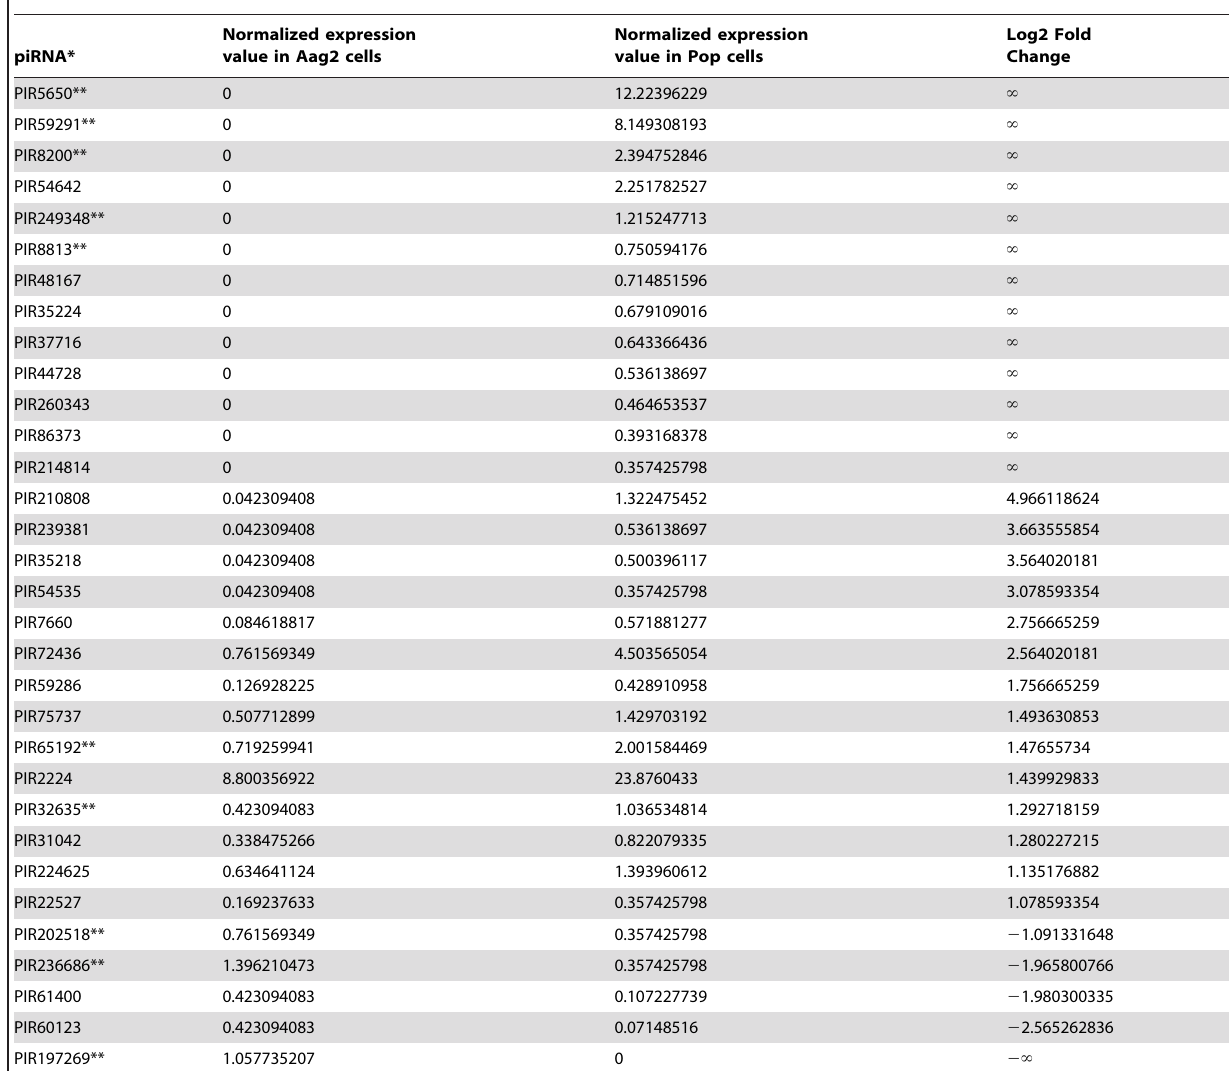
Table 3. Differentially expressed piRNAs in the nucleus of Aag2 cells versus Wolbachia infected cells (Pop).